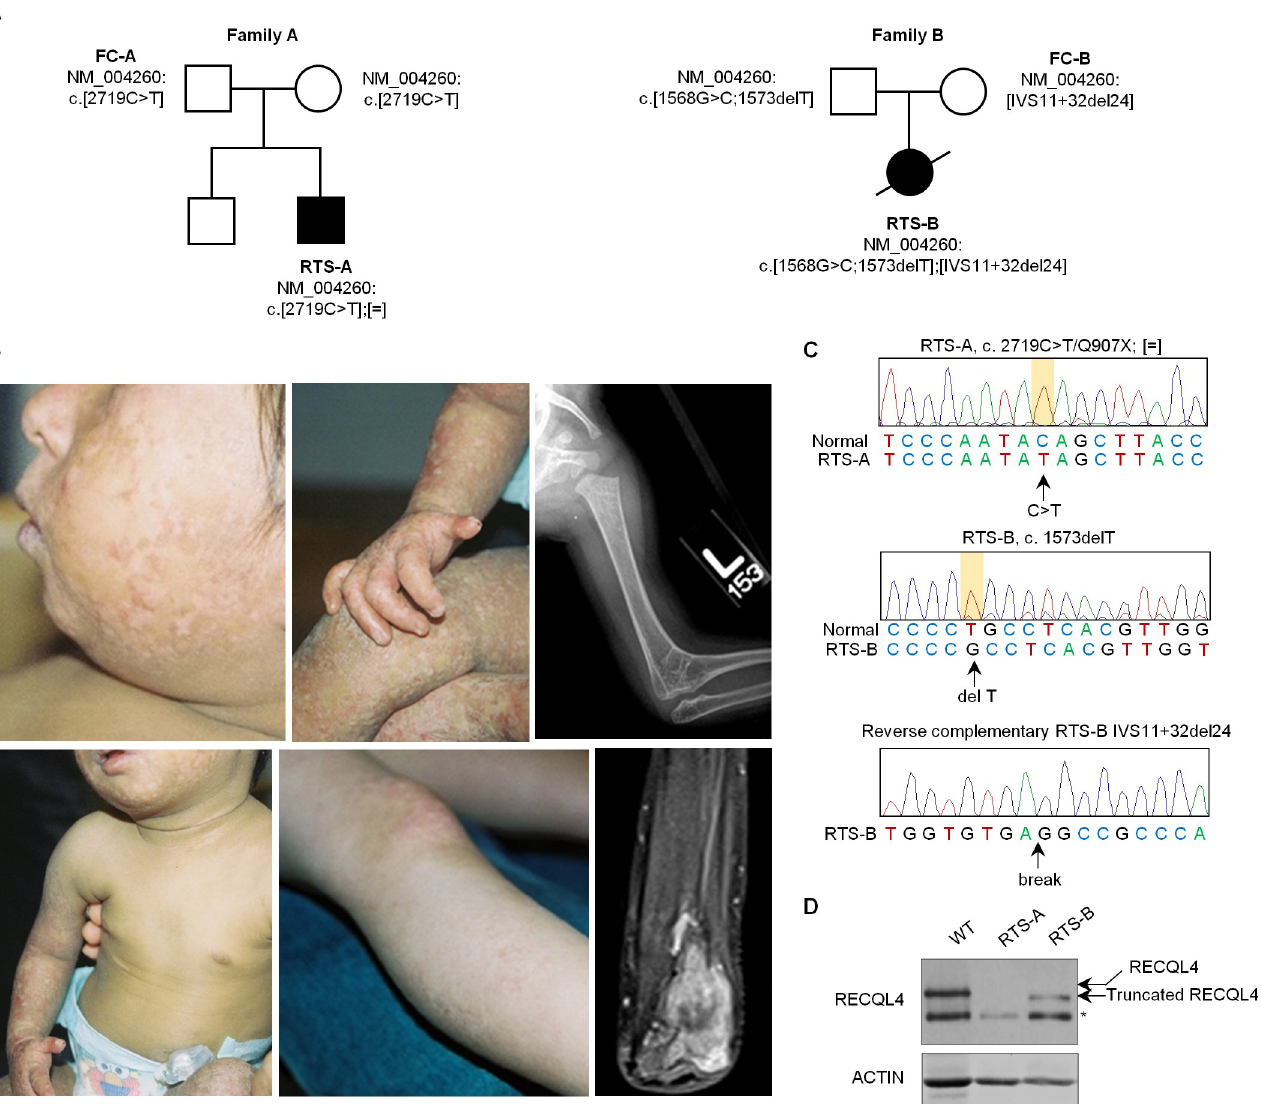
Fig 1. Clinical characterization of Type 2 Rothmund-Thomson Syndrome patients in this study. (A) Pedigrees of the two families with RTS Type 2 and RECQL4 pathogenic variants reported in this study. (B) Photos show the classic poikiloderma on the face, ears, and arms of individual RTS-A at age 2 years (left panels, top and bottom). Note the sparing of the trunk and abdomen as well as sparse scalp hair and absence of eyebrows and presence of gastrostomy feeding tube. Middle panels illustrate variability in the severity of poikiloderma on the lower extremities in RTS-A (upper) and RTS-B (lower). Note hypoplastic thumb and dystrophic nails in RTS-A. Both individuals developed osteosarcoma. The right top panel shows an x-ray of the skeletal defect (radiohumeral synostosis, age 2 years) in RTS-A, and the bottom panel shows an MRI image of osteosarcoma that developed in the right proximal radius of RTS-A at age 10 years. This T1 fat- saturated, coronal, post-contrast view demonstrates diffuse solid enhancement of the tumor with some central areas of non-enhancement. (C) Sanger sequencing verifies biallelic RECQL4 (c. 2719C > T/Q907X) pathogenic variant in RTS-A fibroblasts (upper panel) and RECQL4 (1568G > C;1573delT and VS11 +32del24) in RTS-B fibroblasts (middle and lower panels). (D) Immunoblotting indicates the loss of RECQL4 protein in RTS-A fibroblasts and the truncated RECQL4 protein in RTS-B fibroblasts. � , non-specific band.